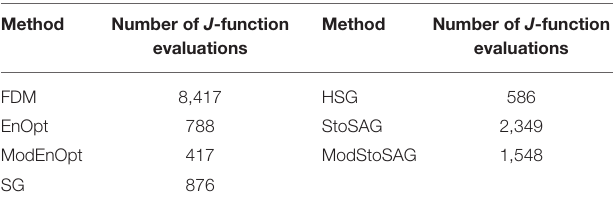
TABLE 2 | Numbers of function evaluations that are needed to achieve 5% of the relative objective function value in Figure 1B